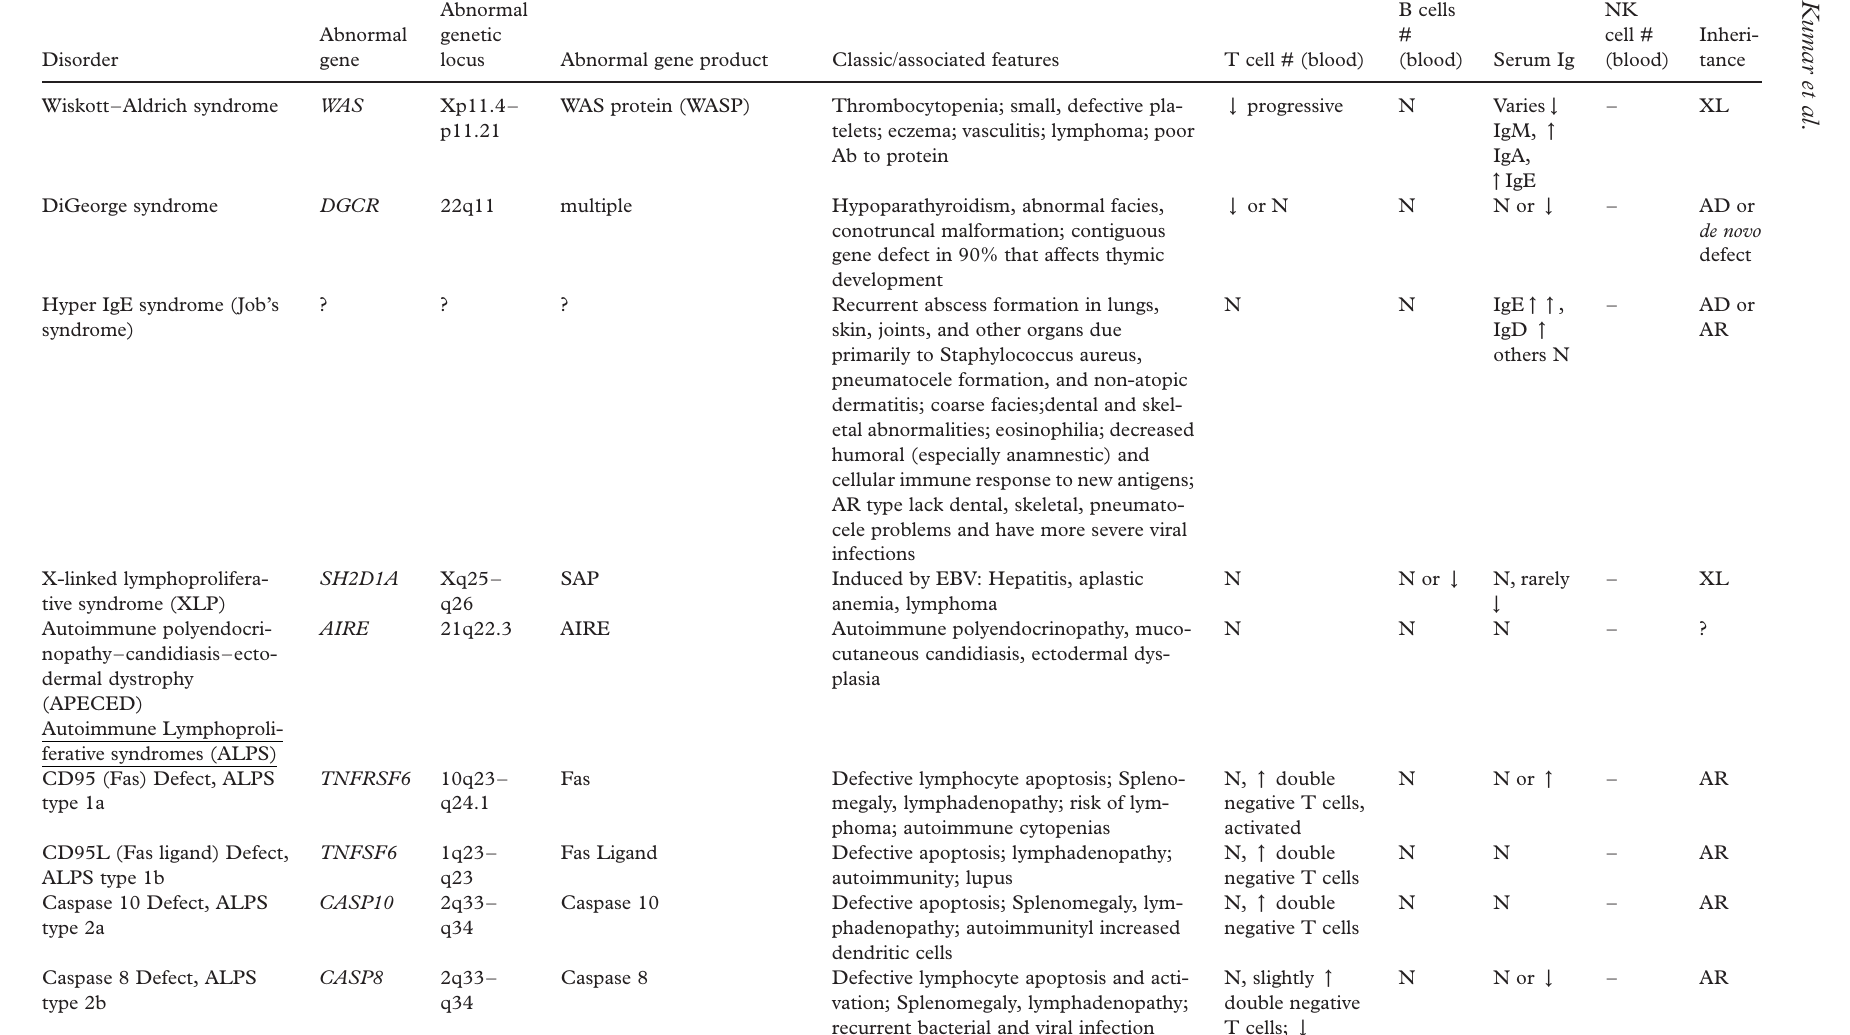
Table VII. Other well-defined immunodeficiency syndromes and